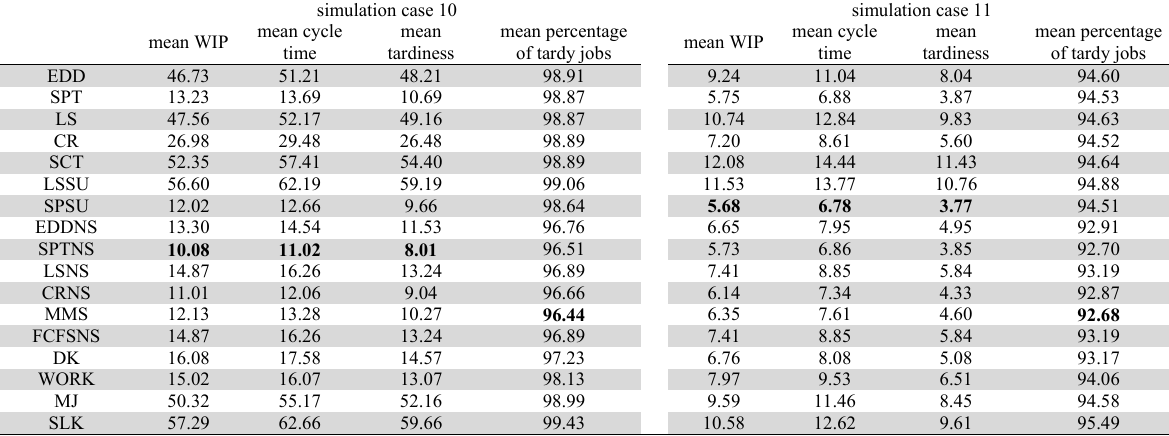
Results for simulation cases 10 and 11. The minimum values for each performance metric and simulation case are denoted in bold simulation case 10 simulation case